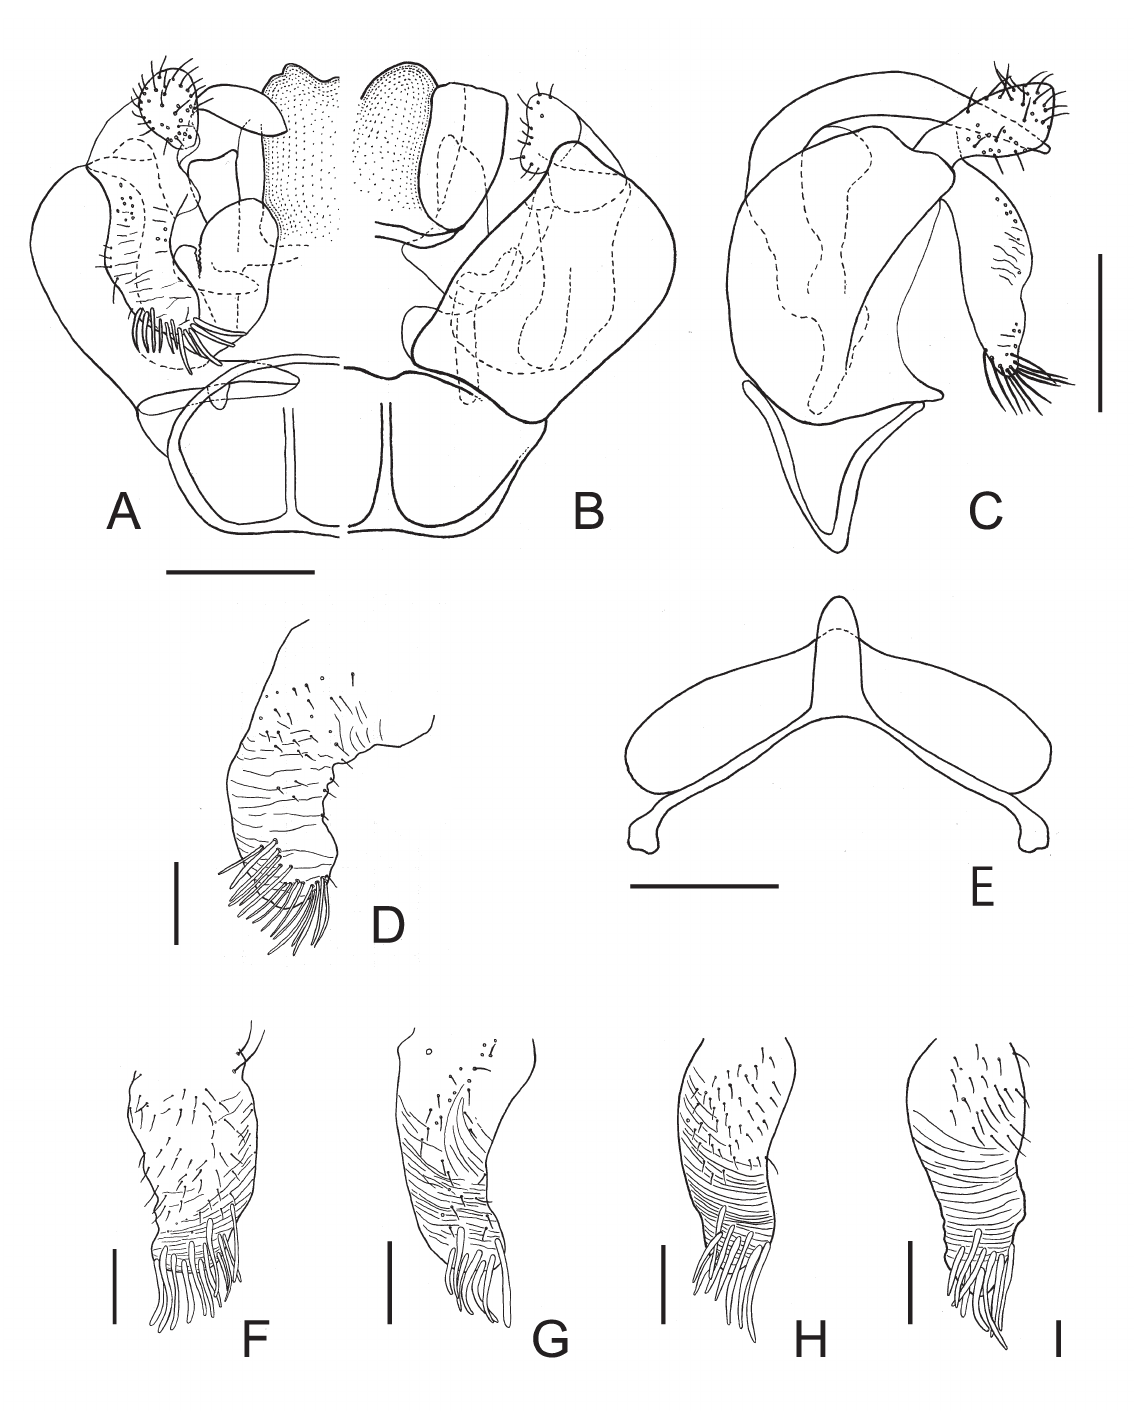
Fig. 2. — A–E . Lasioglossum ( Dialictus ) viridellum (Cockerell, 1931), ♂. — F . L . ( D .) aeratum (Kirby, 1802), ♂. — G . L . ( D .) aligrum (Blüthgen, 1923), ♂. — H . L . ( D .) annulipes (Morawitz, 1876), ♂. — I . L . ( D .) leucopus (Kirby, 1802 ), ♂. A. Genitalia in ventral view. B. Genitalia in dorsal view. C. Genitalia in lateral view. d, F–i. Ventral retrorse lobe of genitalia. e. S7–S8. Scale bars: a–c, e = 0.2 mm, d, F–i = 0.1